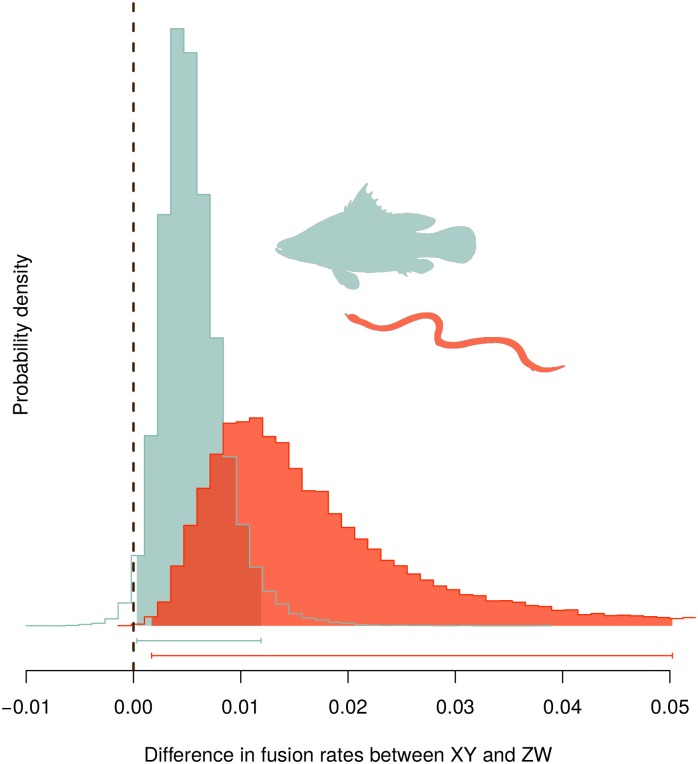
Posterior probability density of the difference in fixation rates of fusions between autosomes and sex chromosomes (rates in XY species minus in ZW species).The plot illustrates the difference in fusion rates over the last 40,000 steps of an MCMC chain, with the 95% credibility intervals shown by the horizontal bars below the figure.